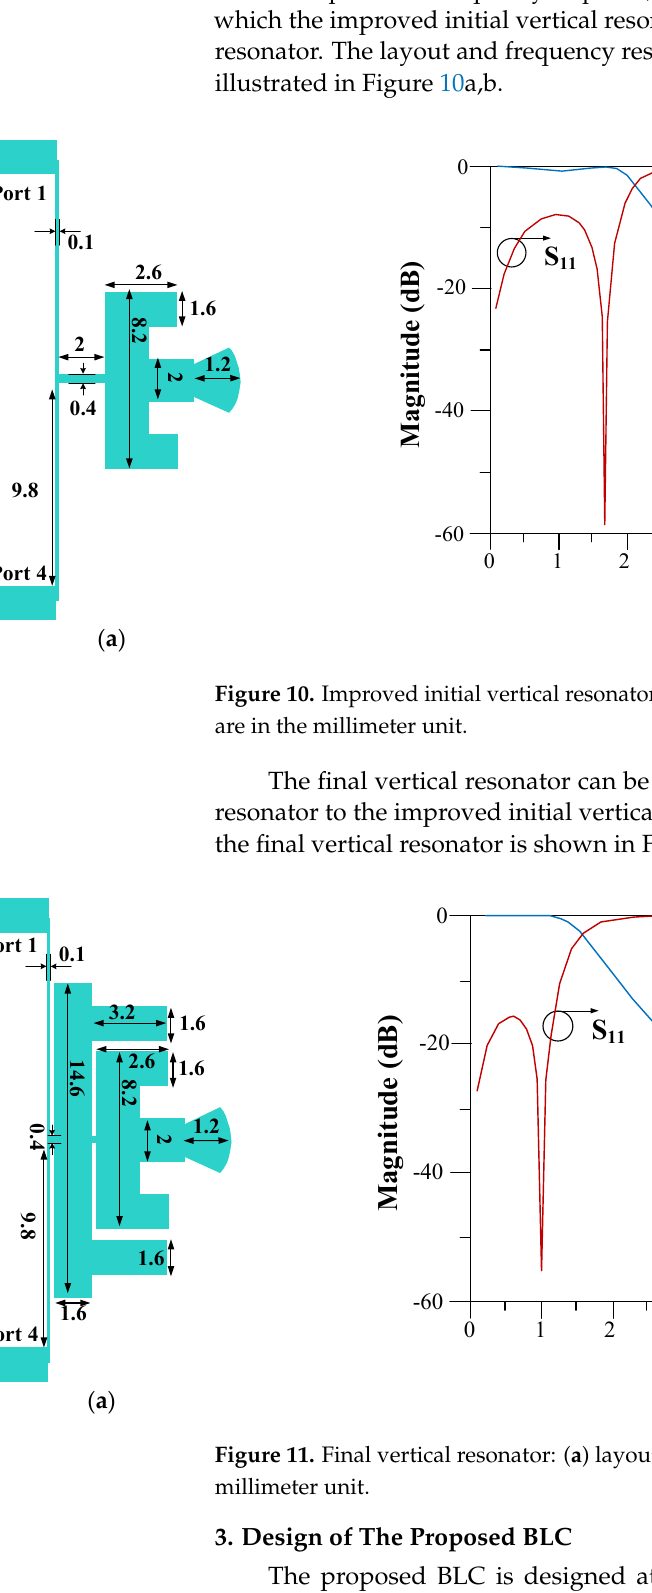
8.2 Figure 12. Structure of the proposed BLC. The structures of the proposed and the conventional BLCs are compared in Figure 13. As seen, the proposed BLC only occupies 20.7 mm× 20.7 mm (0.093 λ × 0.093 λ ), where the conventional one occupies 56.3 mm × 57.2 mm (0.25 λ × 0.25 λ ). The proposed coupler